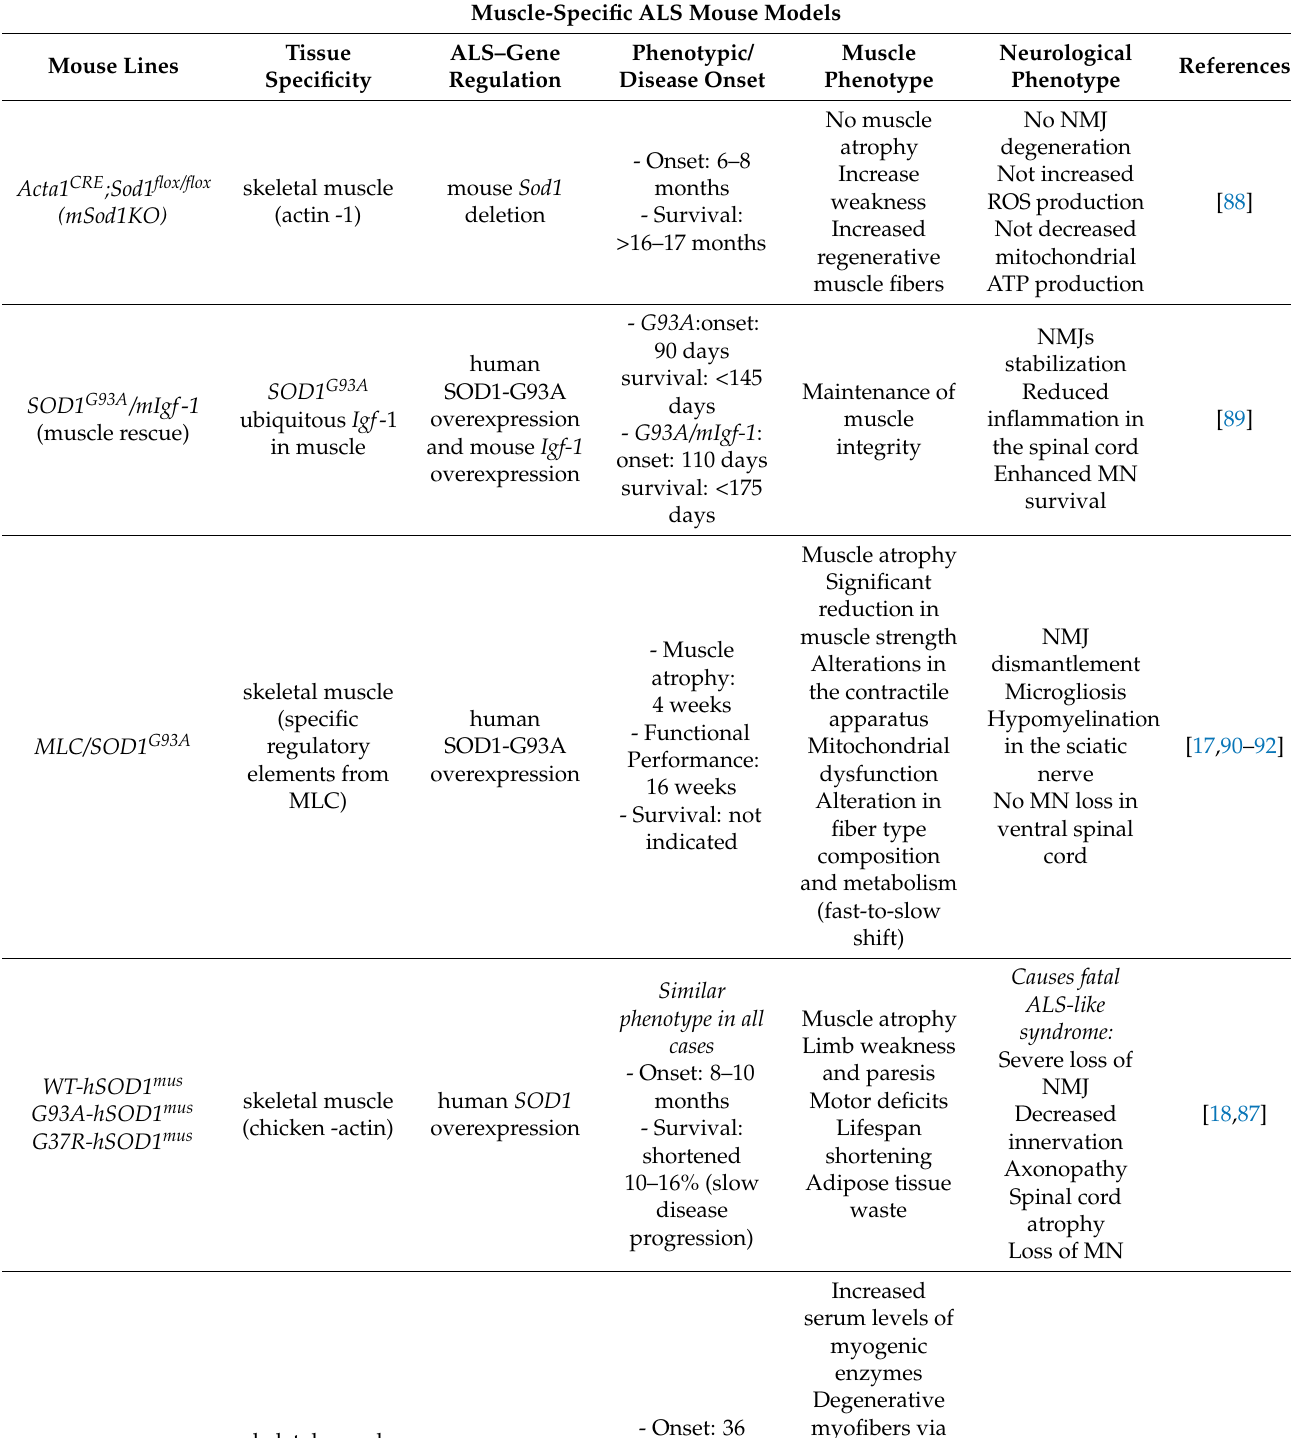
Table 2. Mouse models carrying ALS mutations specifically in the skeletal